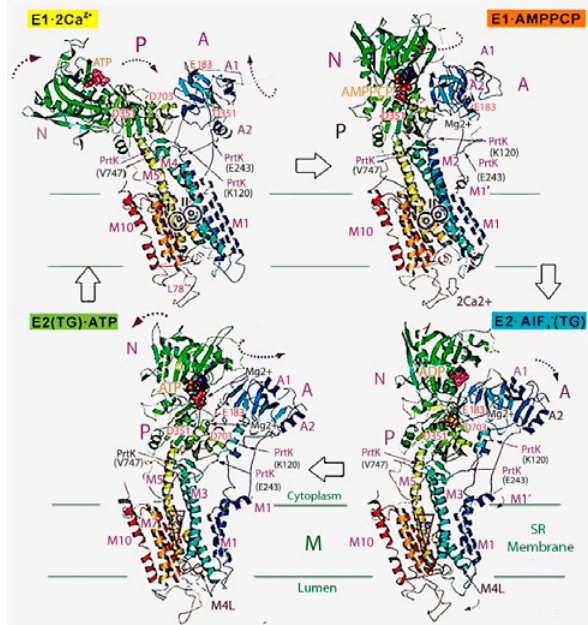
Figure 6. Sequence of conformational states of the calcium ATPase in the presence (E1.2Ca 2+ ), following nucleotide (analog) substrate binding (E1 . AMPPCP), following enzyme phosphorylation (AlF4 analog) and Ca 2+ release (E2.AlF 4. TG) and in absence of Ca 2+ with bound ATP (E2(TG).ATP). 14